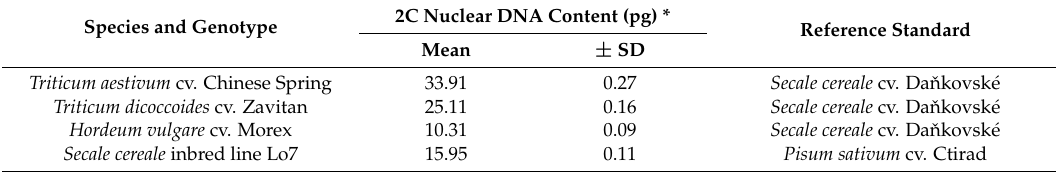
Table 2. Estimation of nuclear DNA amounts in the four Triticeae species. Species and Genotype